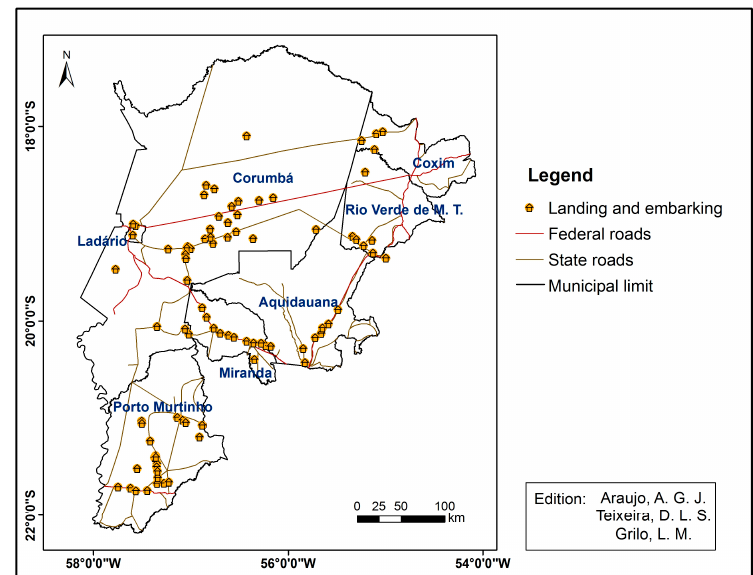
Figure 7. Landing points and rivers—with limits between plain/plateau. Source: Araujo (2018).